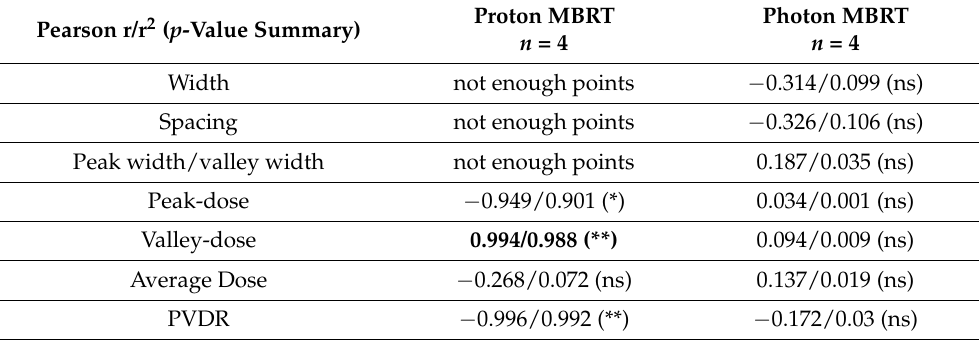
Table 5. Correlation coefficients for the studies including only proton MBRT and photons MBRT. Pearson r/r 2 ( p -Value